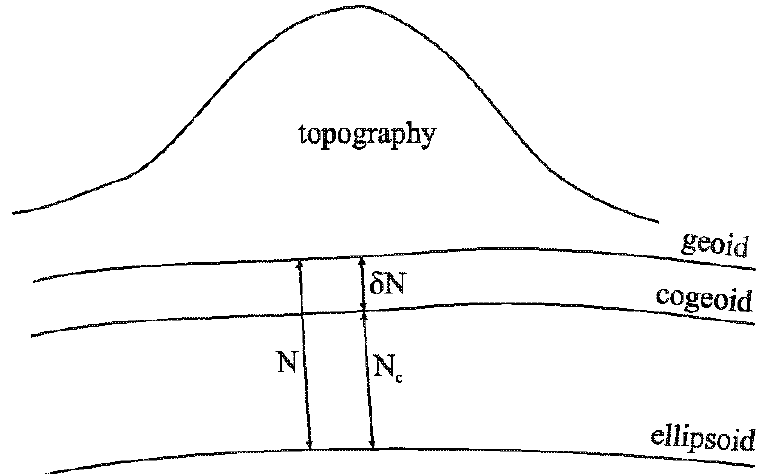
Figure 1. Geoid and cogeoid.